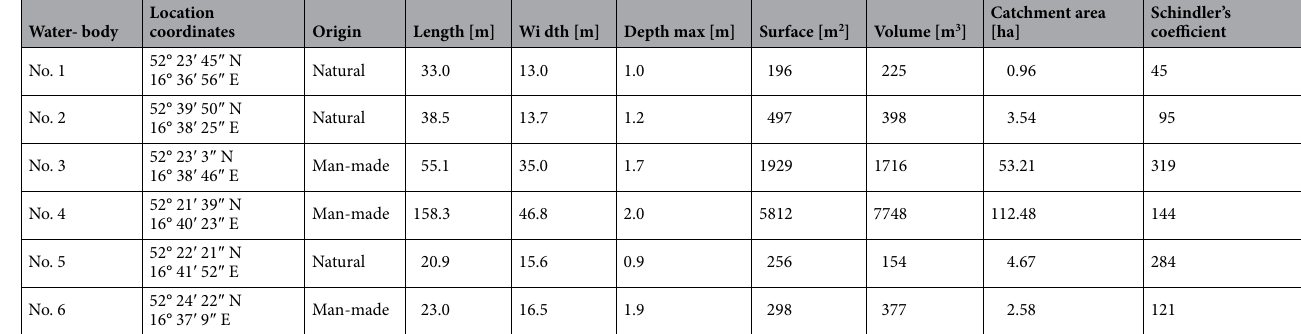
Table 1. The characteristics of the waterbodies (according to Szpakowska et al. 23 , changed).